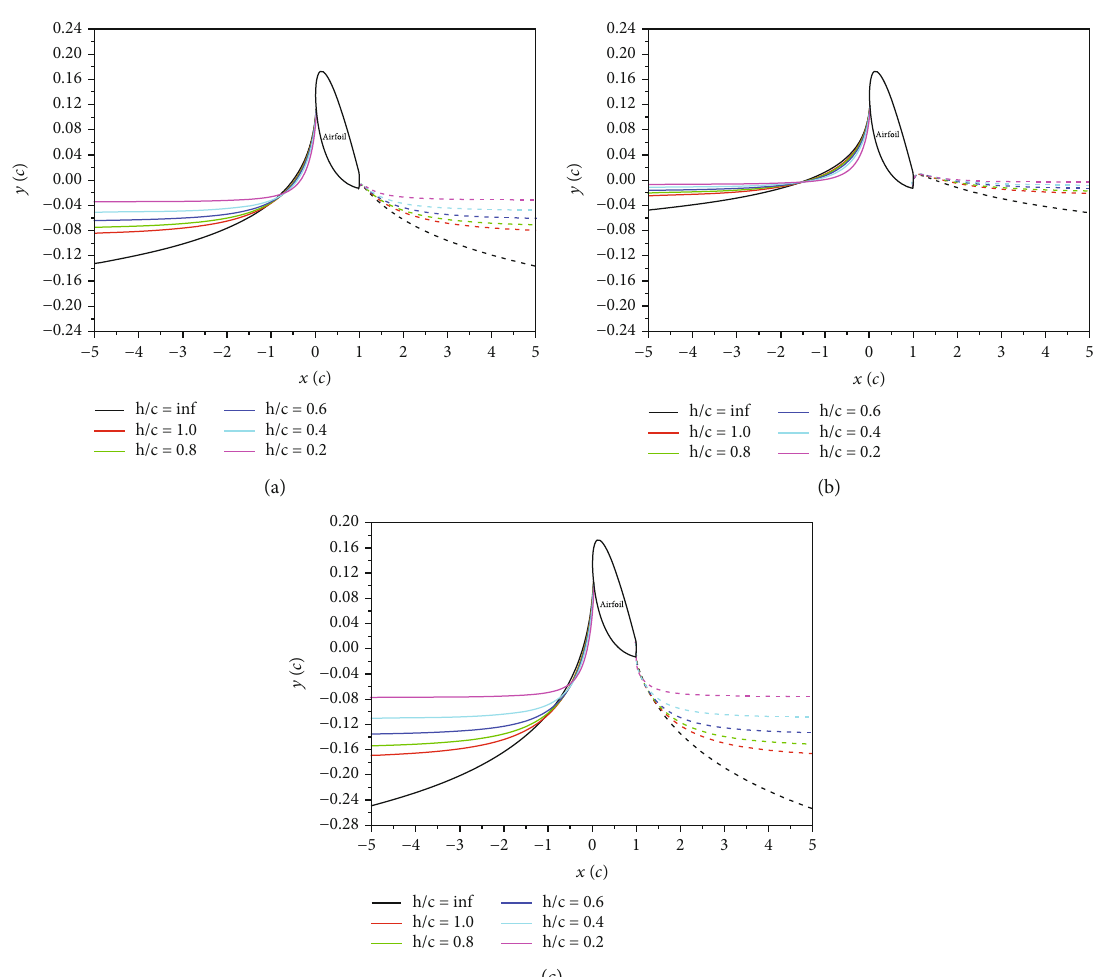
= − 0 : 013 ; (c) with C = 0 : 013 . μ μ